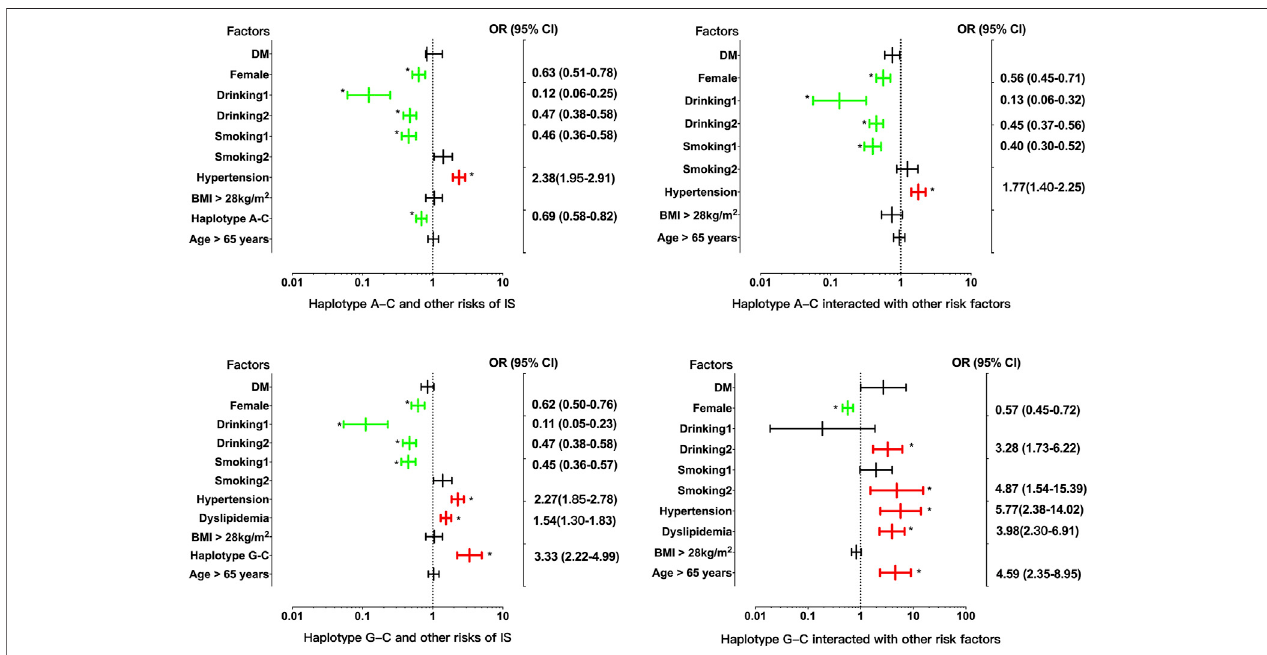
FIGURE 2 | Associations between the EHBP1 haplotypes, environmental factors, and their interactions on ischemic stroke. p < 0.025 was considered statistical signi fi cance after the Bonferroni correction for two haplotypes. The red and green colors in the picture mean the increased risk and decreased risk factors, respectively.